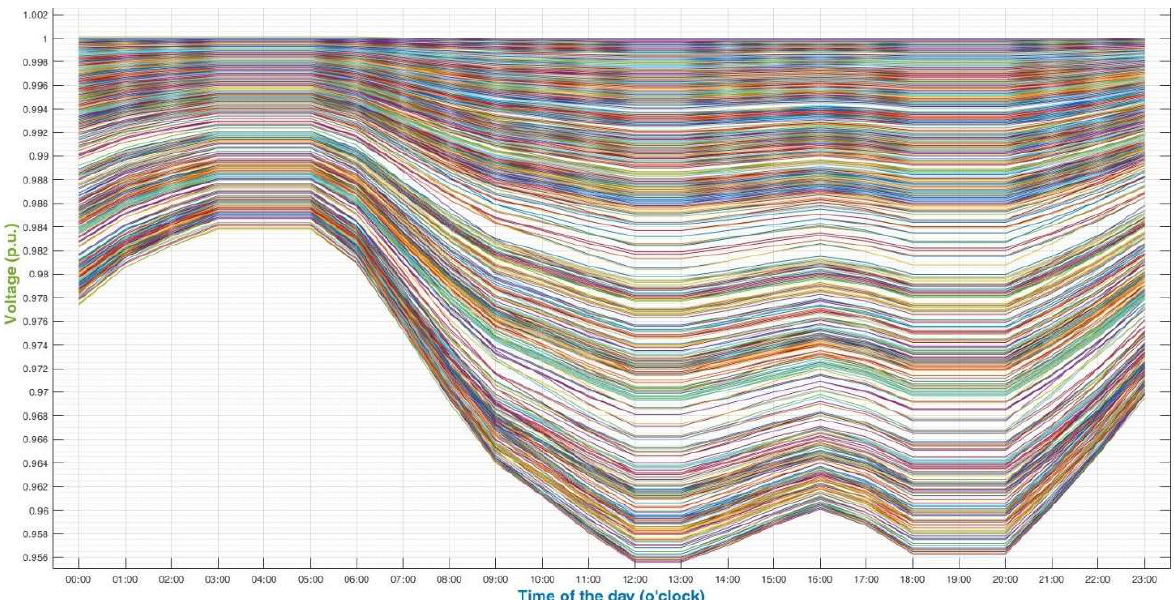
Figure 9. Transformer capacity usage without considering PEV charging.